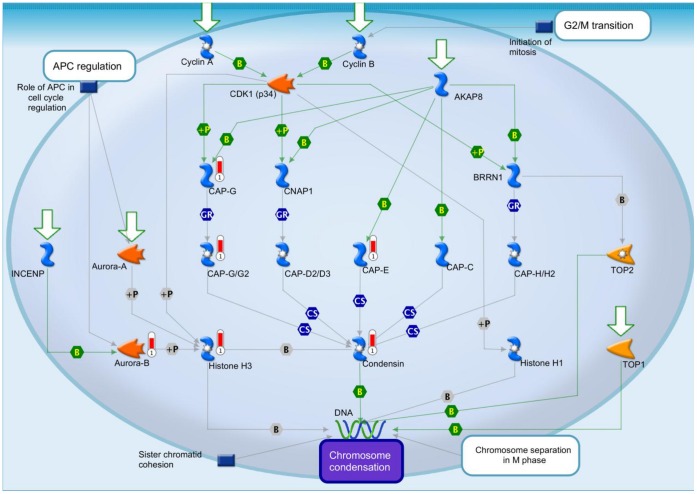
The G2/M transition is the major signaling pathway altered by Hltf deletion.Significant decreases (red thermometers = negative effects) in transcript expression of major components of the G2/M transition in Hltf null brain are superimposed on the proprietary multicomponent canonical pathway map from the MetaCore™ database [Straight lines = interactions; Symbols = events; +P = phosphorylation; B = binding; GR = group relation; CS = complex subunit. Colors for lines and symbols are green for positive, and gray for unspecified].